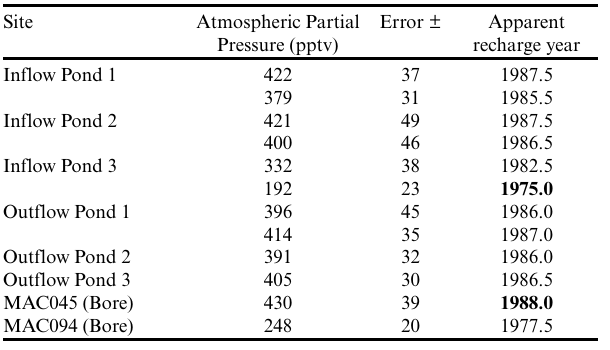
Table 3 . Groundwater dating results: CFC-12. The endpoints of the range of apparent recharge estimates are bold.